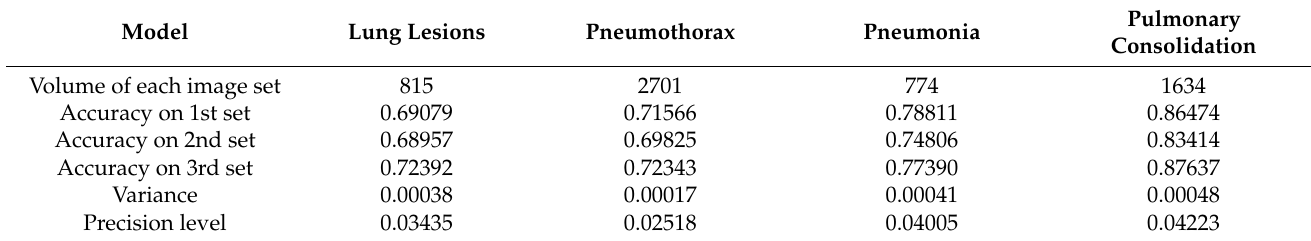
Table 4. Partial considerations for precision levels for each model.